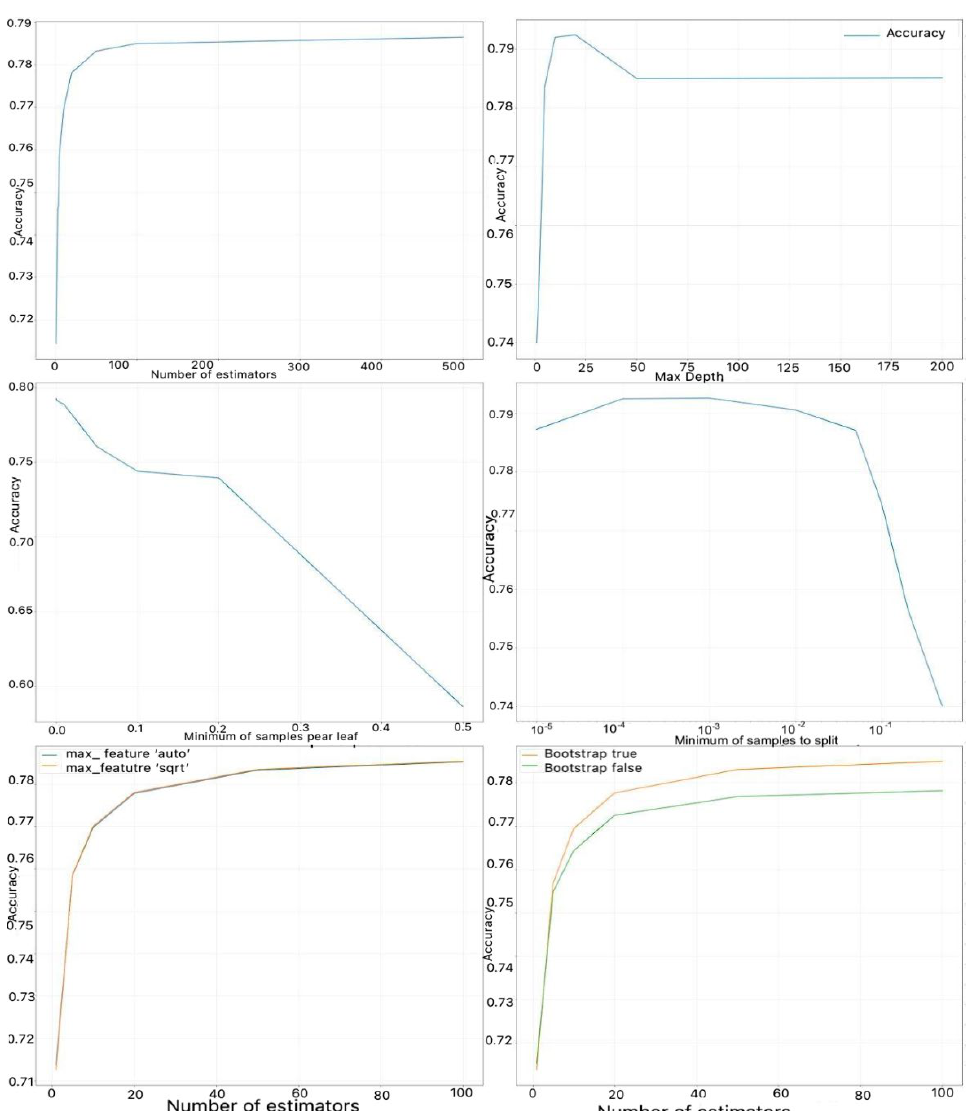
Figure 9. Changing one parameter while keeping the others fixed.